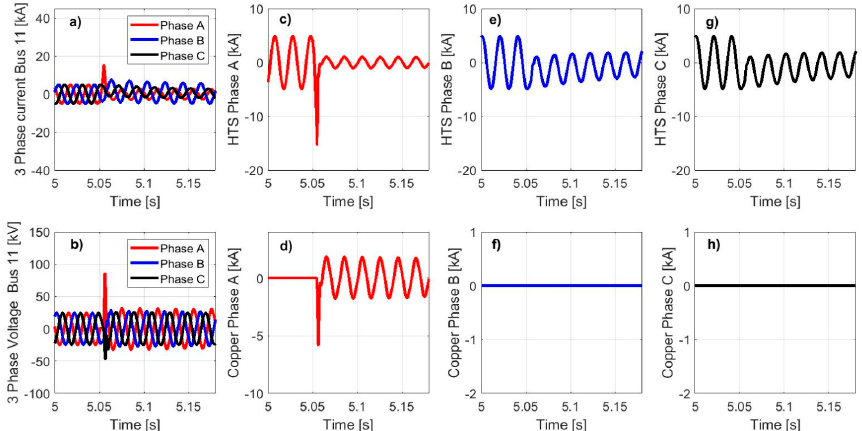
Figure 11. Fault current signatures for Phase-A-to-ground solid fault at 50% of cable’s length.: ( a ) phase currents at Bus 11, ( b ) phase voltages at Bus 11, ( c ) current in HTS layer of phase A, ( d ) current in copper layer of phase A, ( e ) current in HTS layer of phase B, ( f ) current in copper layer of phase B, ( g ) current in HTS layer of phase C, ( h ) current in copper layer of phase